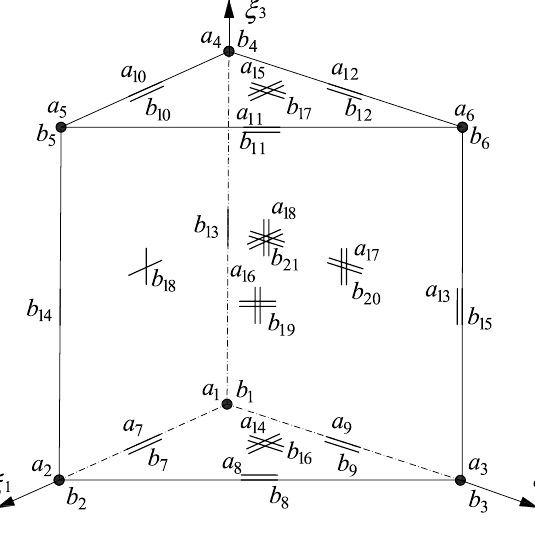
Figure 2. An exemplary principal geometry II of the transition